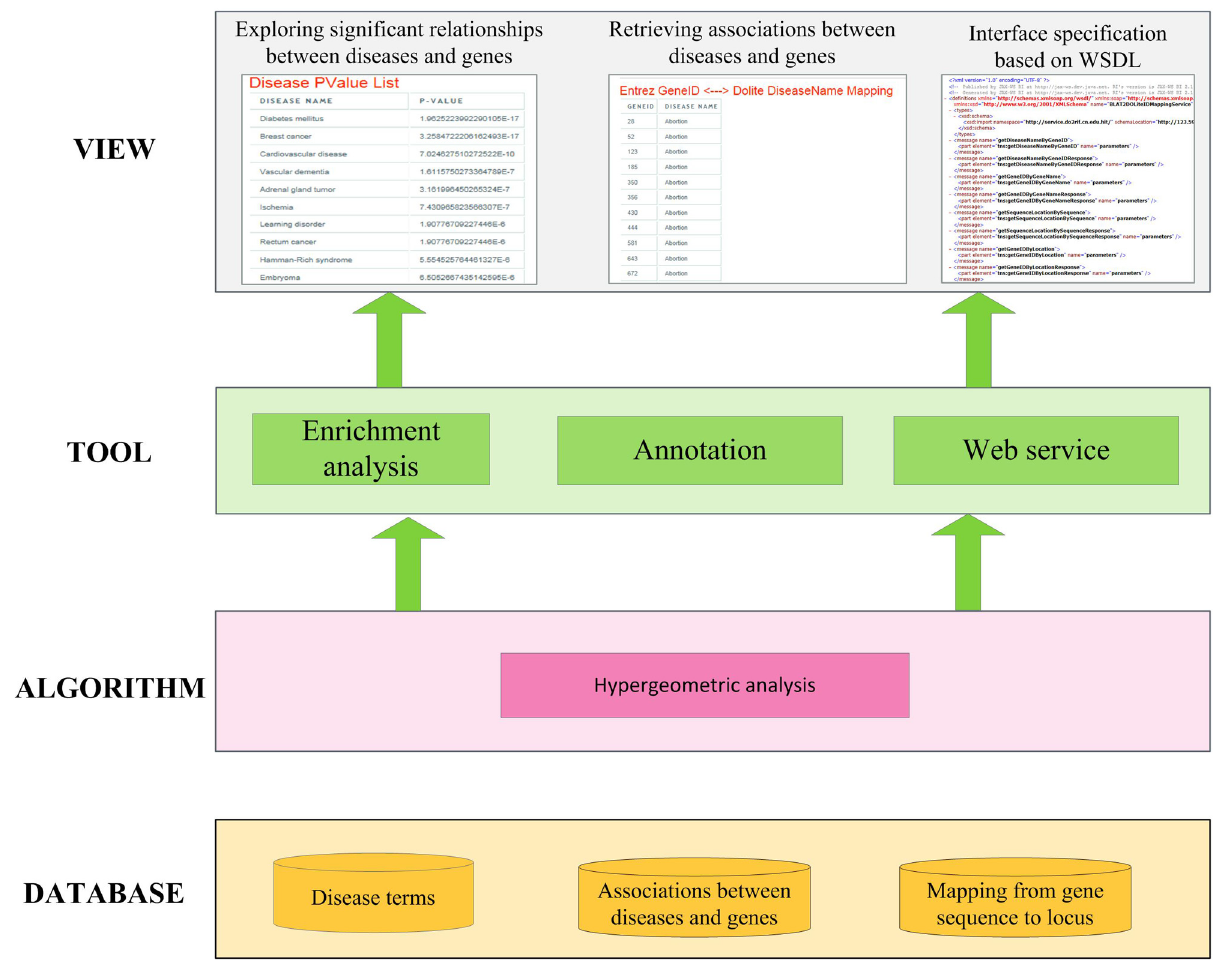
Fig 2. System overview of